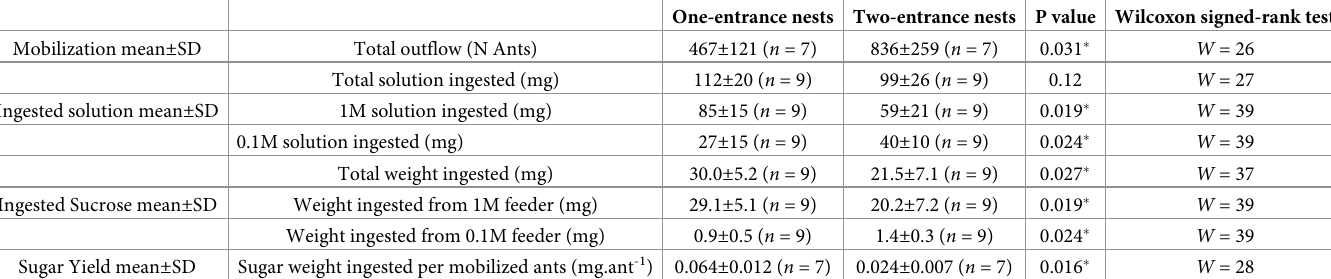
Table 1. Foraging efficiency of ant colonies kept in one-entrance and two-entrance nests. One-entrance nests Two-entrance nests P value Wilcoxon signed-rank